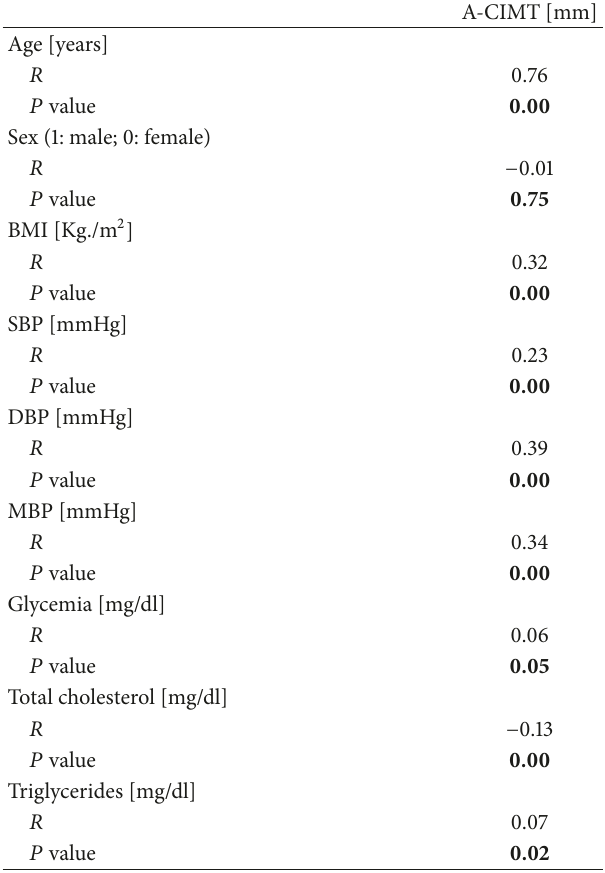
Table2:Comparativestudyofleftandrightcommoncarotidintima media thickness (CIMT).